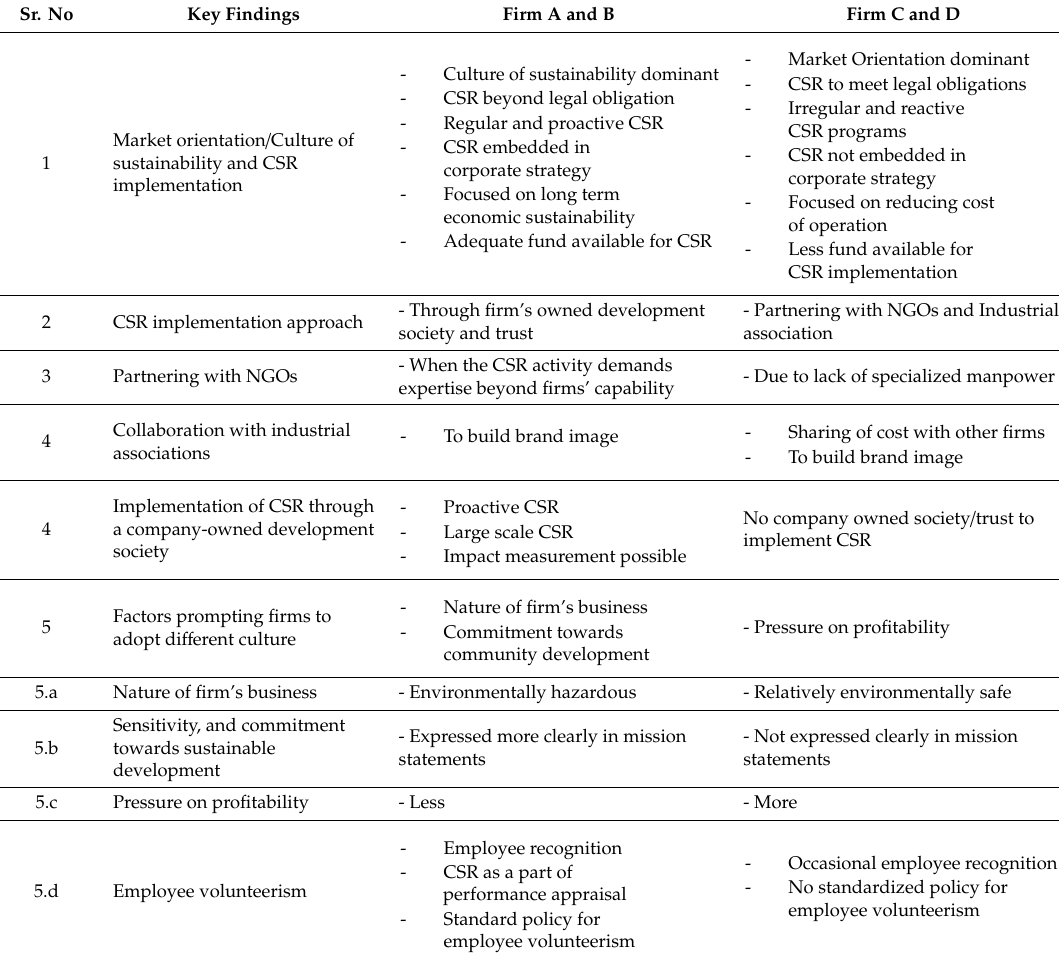
Table 3. Comparative analysis of sample firms and summary of